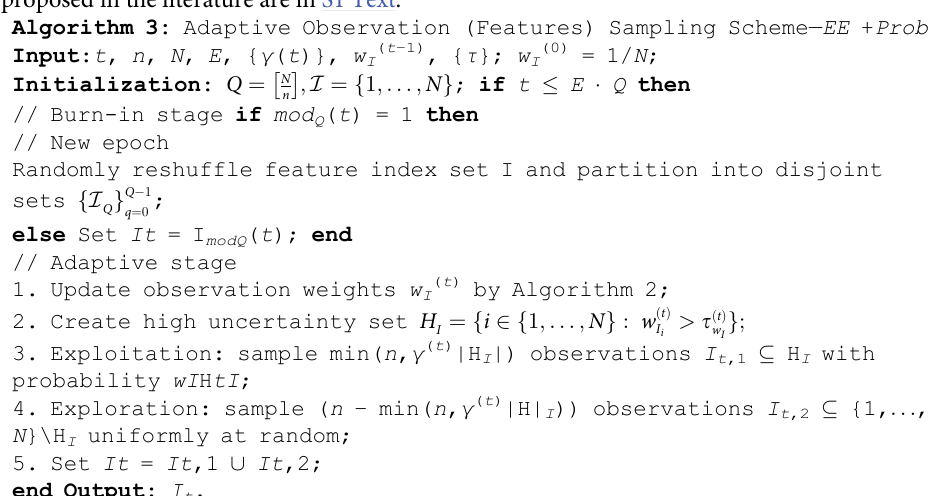
Algorithm 3: Adaptive Observation (Features) Sampling Scheme— EE +